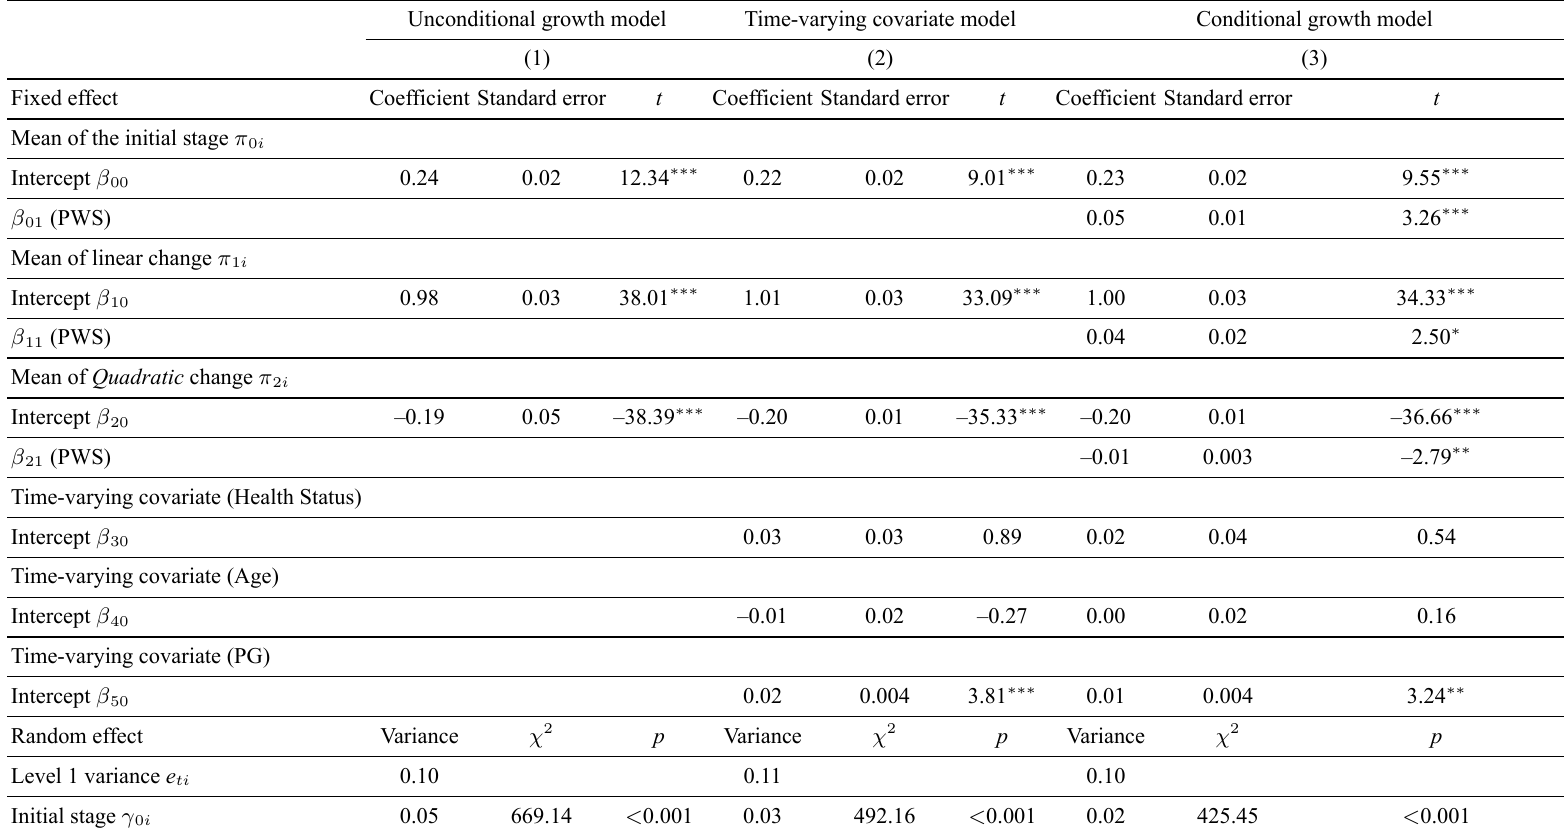
Table 3. Summary of HLM multilevel growth model